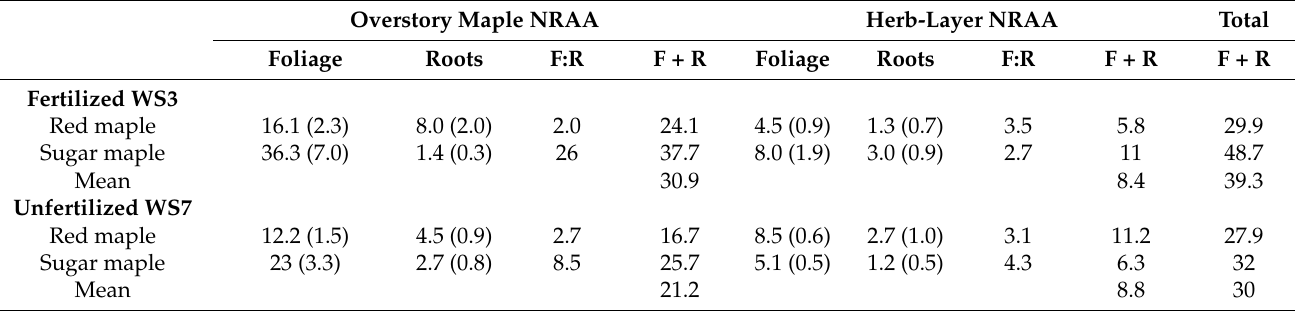
Table 6. NRAA ( µ mol NO 2 − m − 2 hr − 1 , standard error in parentheses) of foliage and fine roots (0–10 cm) for the overstory maples and herb layer in fertilized watershed (WS) 3 and unfertilized WS7. F:R refers to the ratio of foliage to root NRAA. Standard Error is based on a maximum of n =